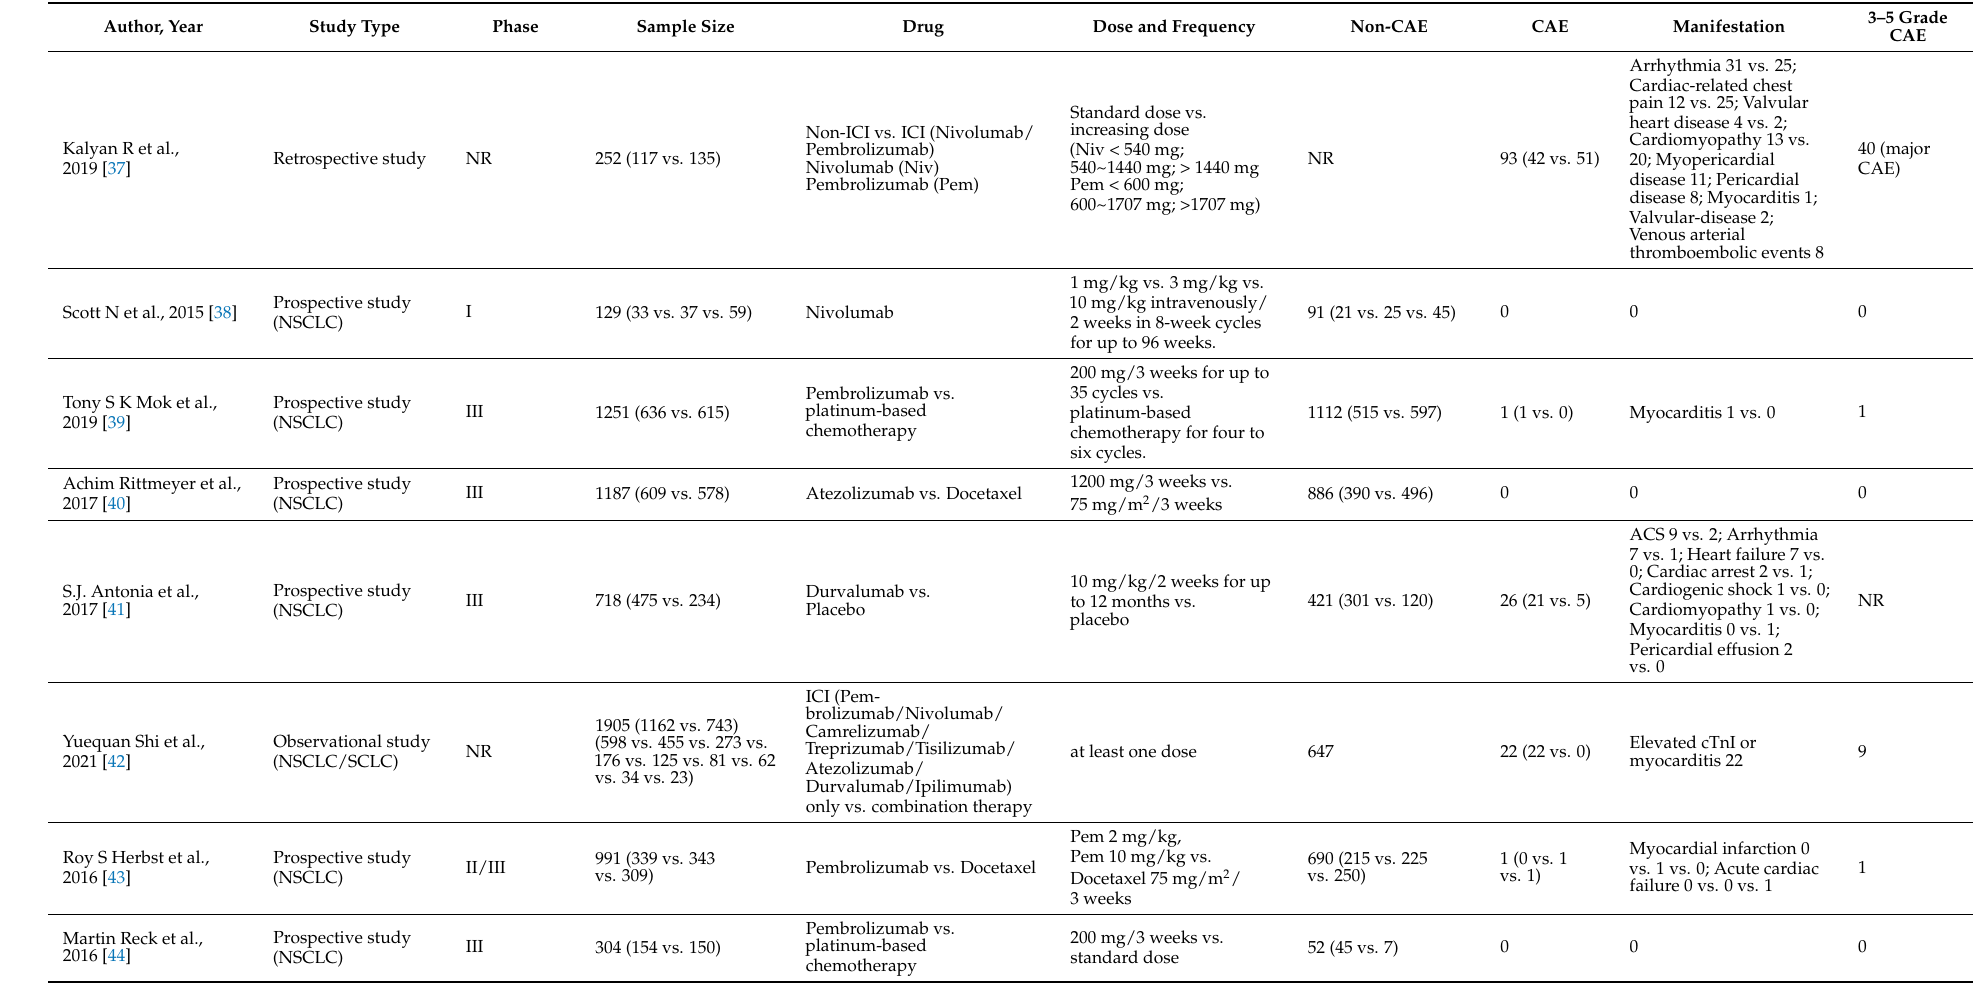
Table 2. Cardiotoxicity in lung